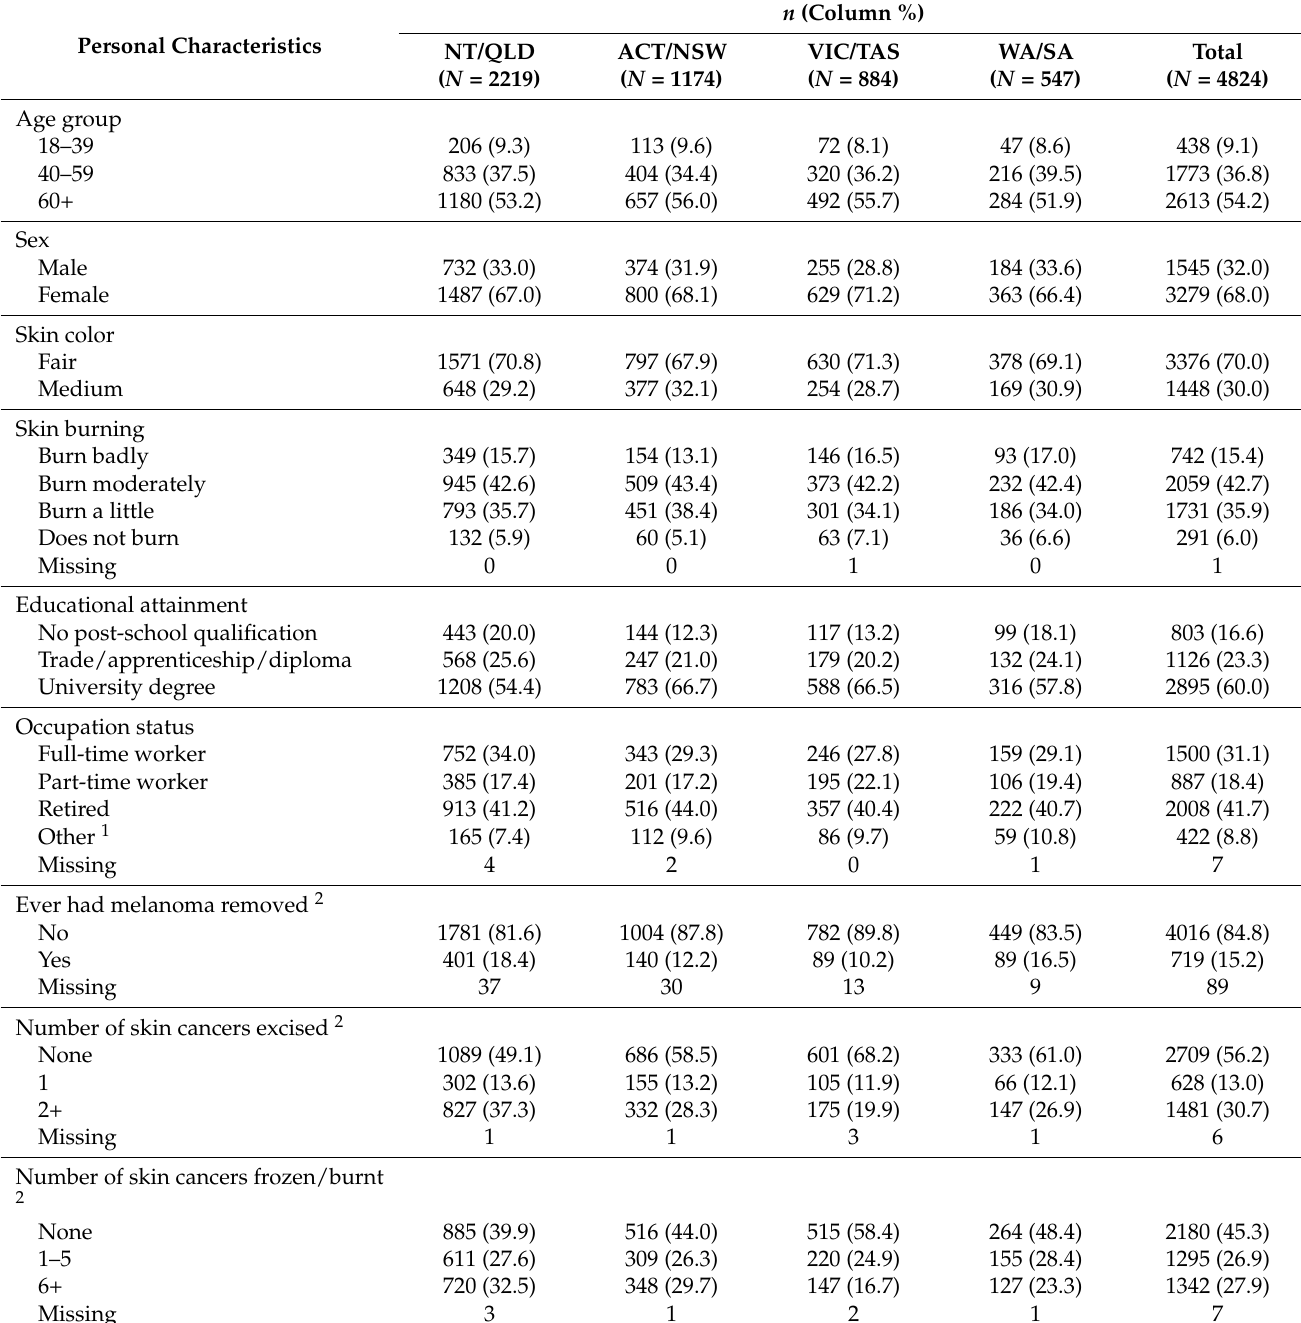
Table 2. Participant characteristics by state/territory of